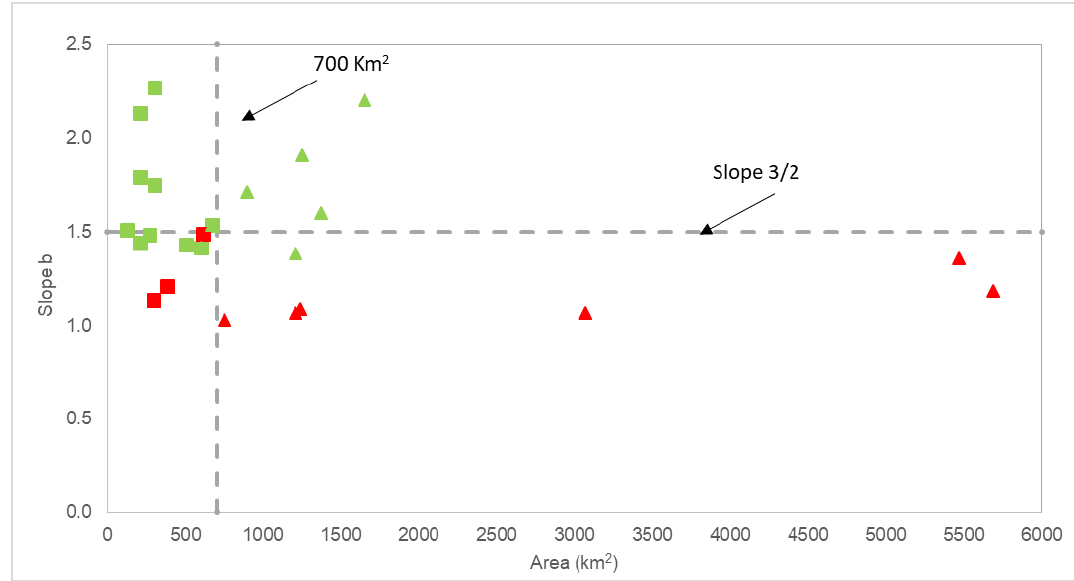
Figure 9. The relationship between slope b and watershed areas. Watersheds of the Central Valley (red) and watersheds of the Andes Mountains (green). Rectangles represent watersheds with areas less than 700 km 2 and triangles represent watersheds with areas over 700 km 2 .